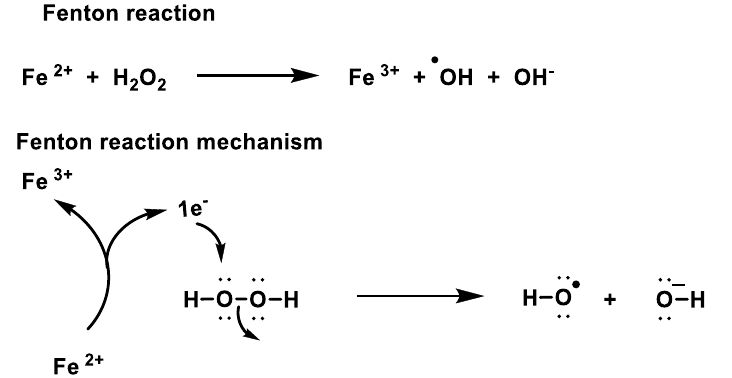
Figure 13. Mechanism of the Fenton reaction.